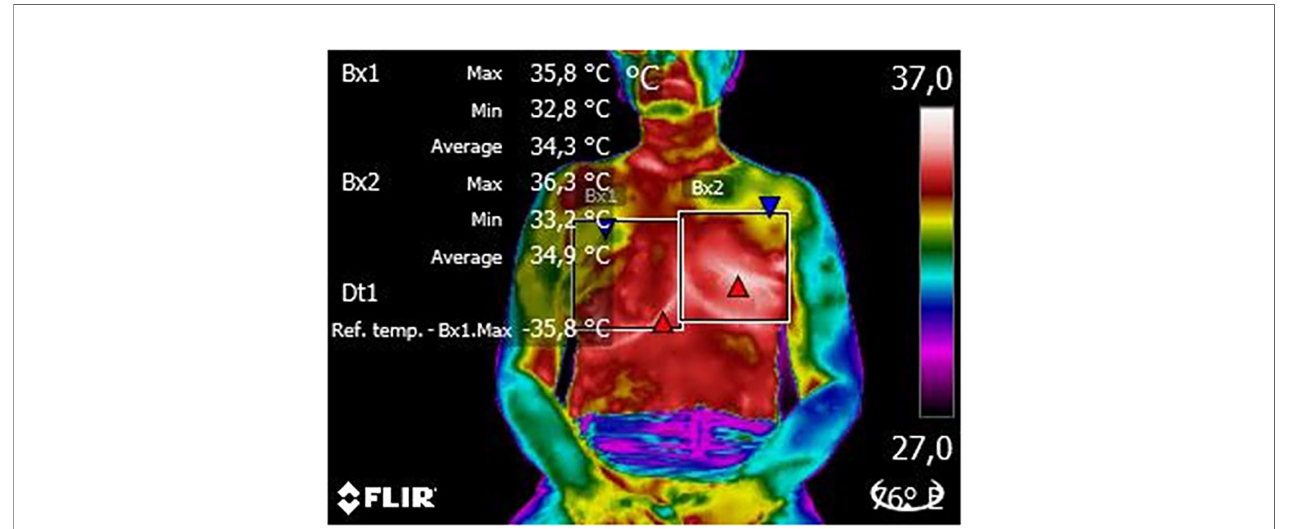
FIGURE 2 | Thermogram of an evaluated patient thermogram. From this image, it is possible to observe the delimitation of the region of interest (white squares), the color palette (frow lowest to highest temperature) used to identify probable changes and the patient ’ s position (seated) to capture the image. On the right, we can see the patient´s breasts (in red and yellow) while on the left, there is the plastron region (in red) and the mastectomy scar (in